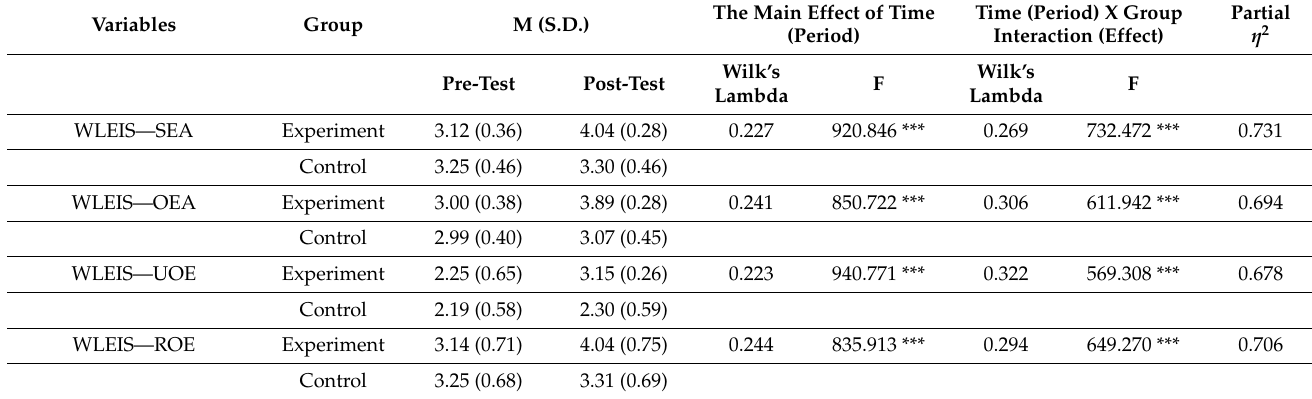
Table 5. The Main Effect of Time (Period), and Interaction Effects Between Time (Period) and Group, in the Participants’ WLEIS and ARP Scores from the Results of the Repeated Measures Analysis of Variance for WLEIS and